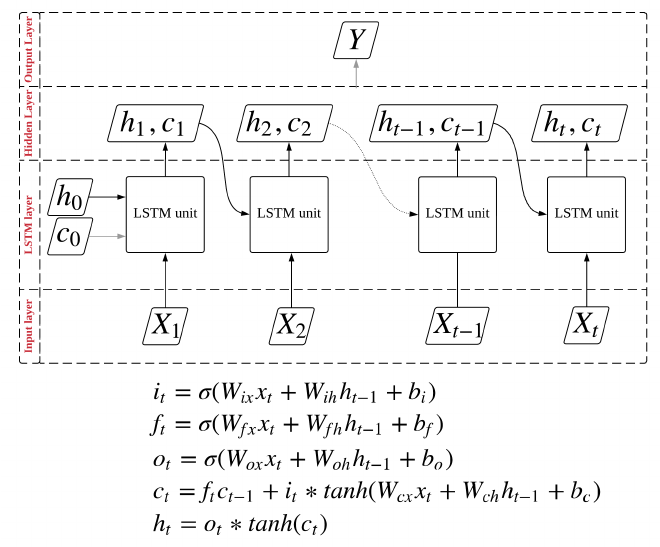
Figure 4. Structure of LSTM. Similar to RNN (Figure 3) but adding memory cell c . i , f , o are the input gate, forget gate and output gate respectively. σ is the sigmoid